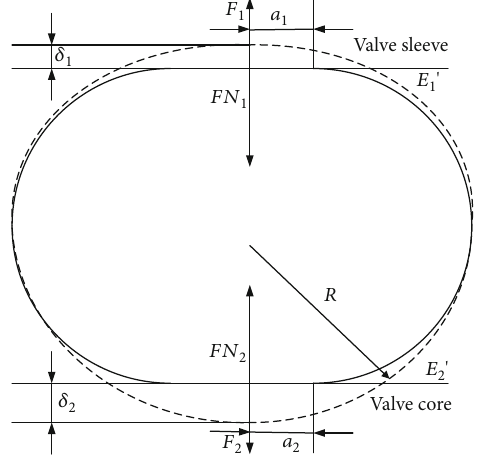
Figure 18: Interaction model between contamination particles and motion pair surfaces.